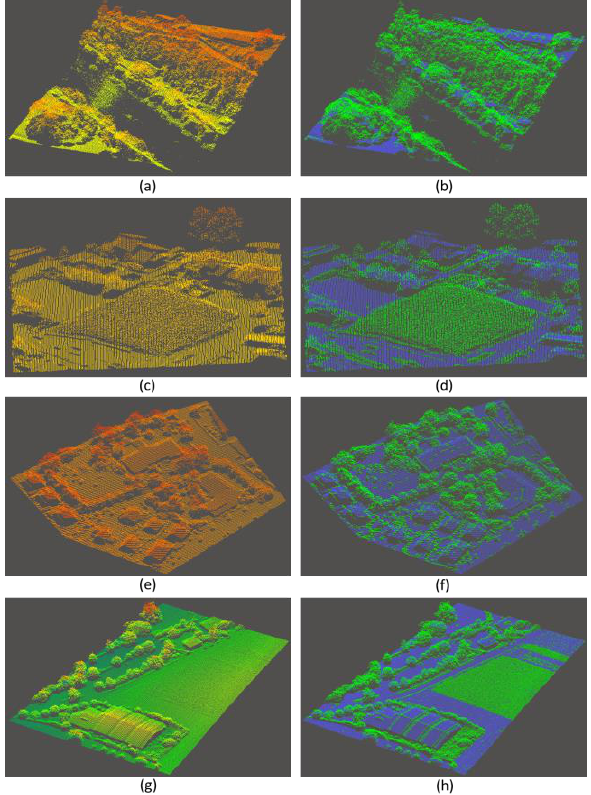
Figure 5. Experimental results of the airborne LiDAR dataset. (a) The source point cloud, and (b) the vegetation removal result of the banks along the river. (c) The source point cloud, and (d) the vegetation removal result of a grass land area. (e) The source point cloud and (f) the vegetation removal result of a residential area. (g) The source point cloud and (h) the vegetation removal result of a farmland area.